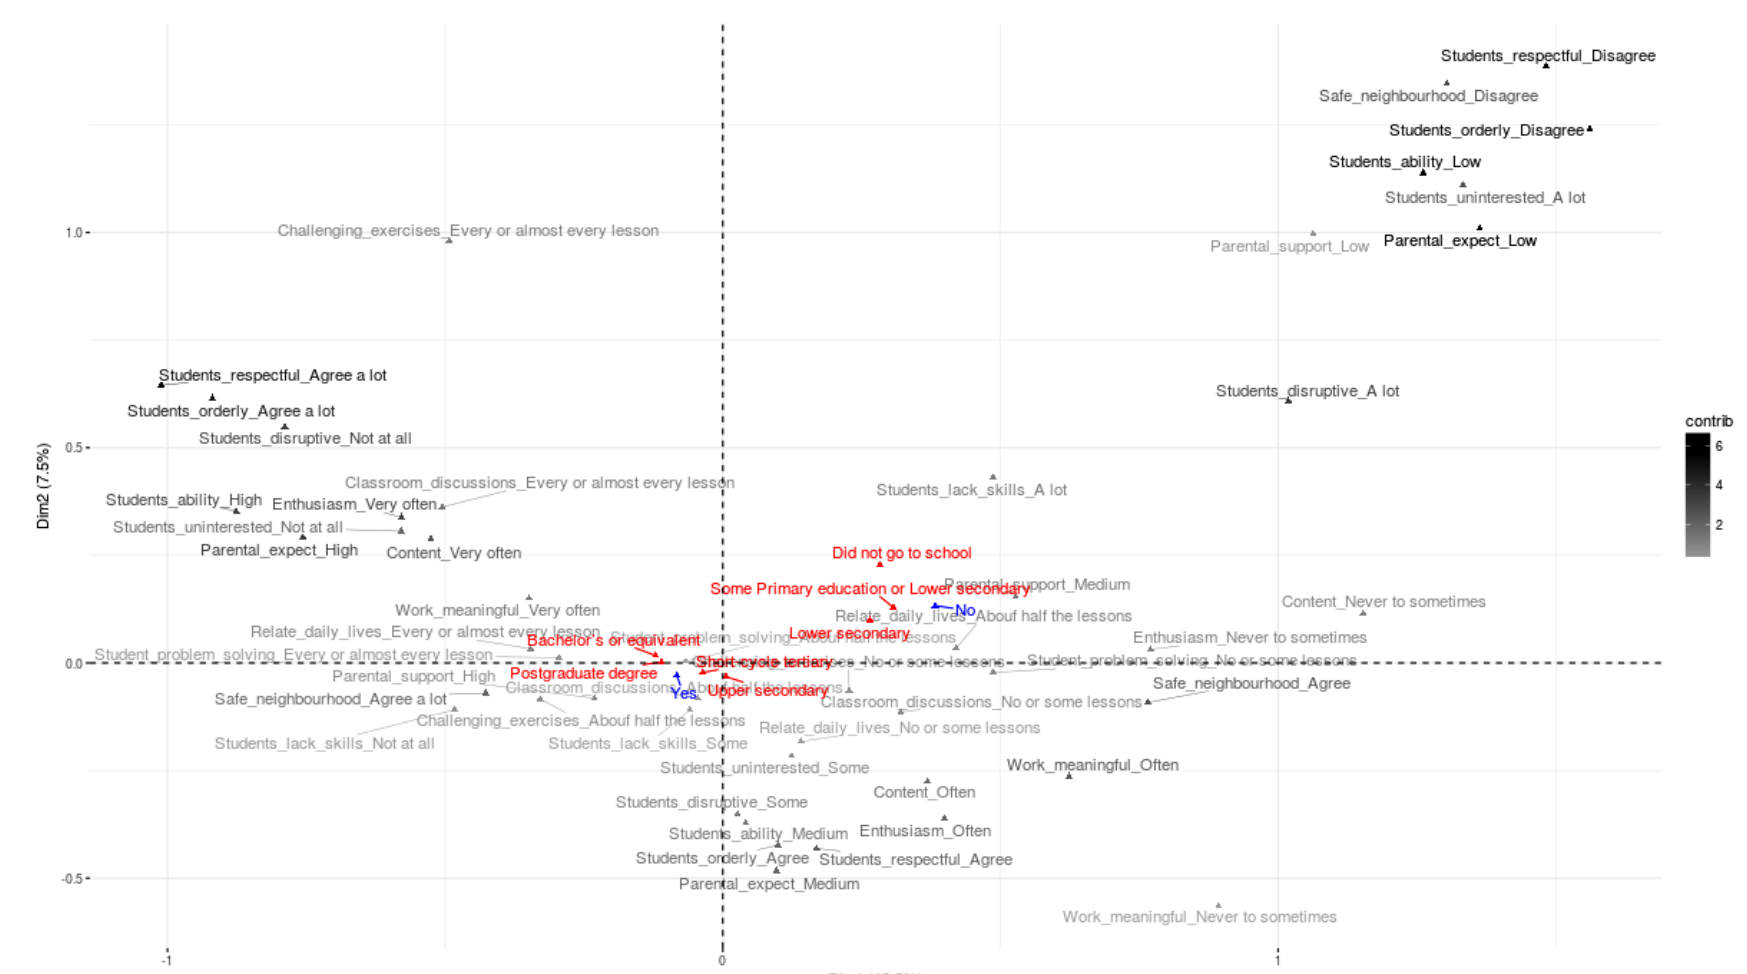
Figure 1. “Educational space of problematization” and background variables. Notes: 21,5% of total inertia explained; more influential variables coloured darker. Passive variables: blue: father born in Germany (yes/no), red: father’s educational level. Categories of some items merged to increase readability and balance skewed distributions. Active Variables taken from teacher questionnaire (N = 307), passive variables taken from the home questionnaire (N =